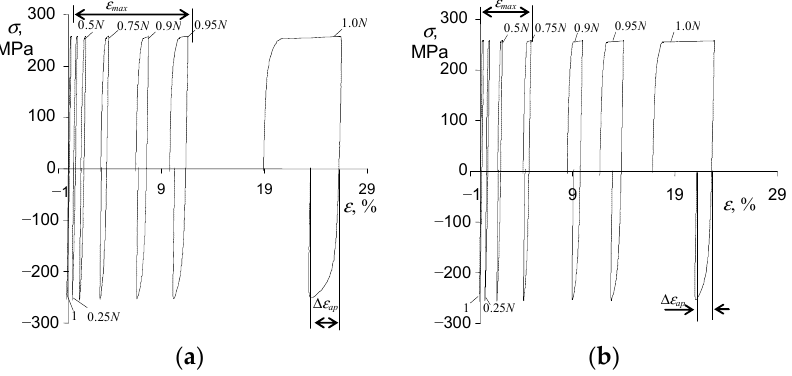
Figure 9. Hysteresis loops in creep-fatigue conditions for σ a = 258 MPa, and ( a ) τ = 5 s, ( b ) τ = 30 s.